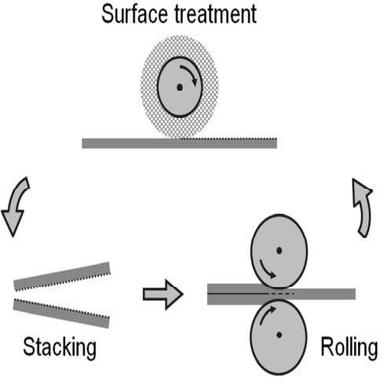
Scheme of the Accumulative Roll Bonding process according to .